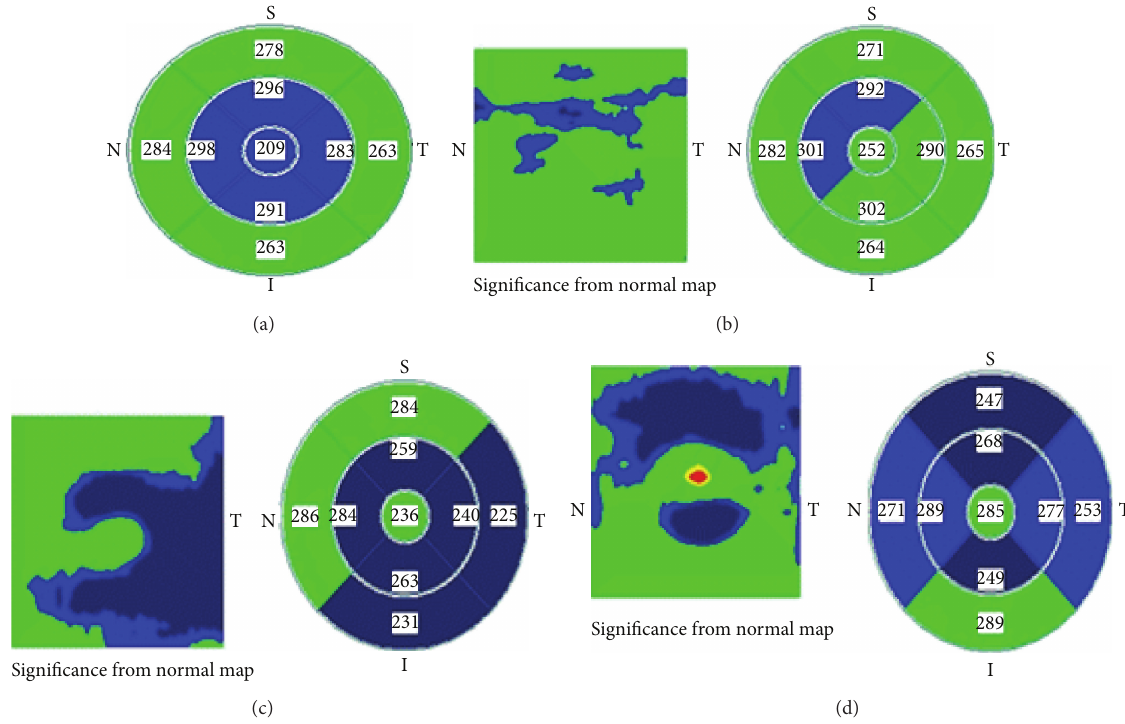
Figure 1: EMM5 maps from some patients in the Chloroquine group (Green is within normal; Blue is below normal). (a) EMM5 map showing thinning in the CFT as well as all parafoveal quadrants. (b) Parafoveal affection (c and d) parafoveal with perifoveal affection.